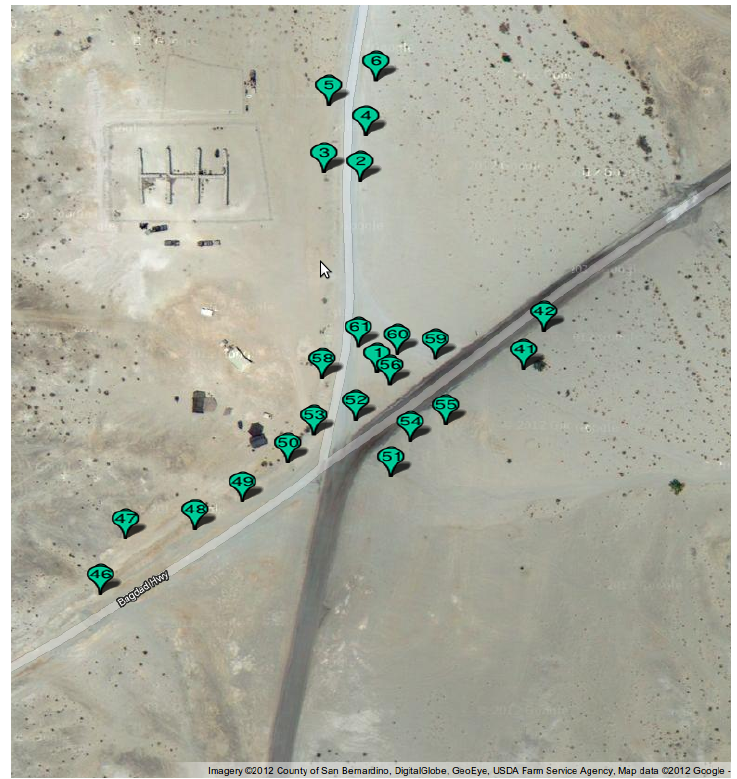
Figure 3. Google maps view of the SITEX02 network